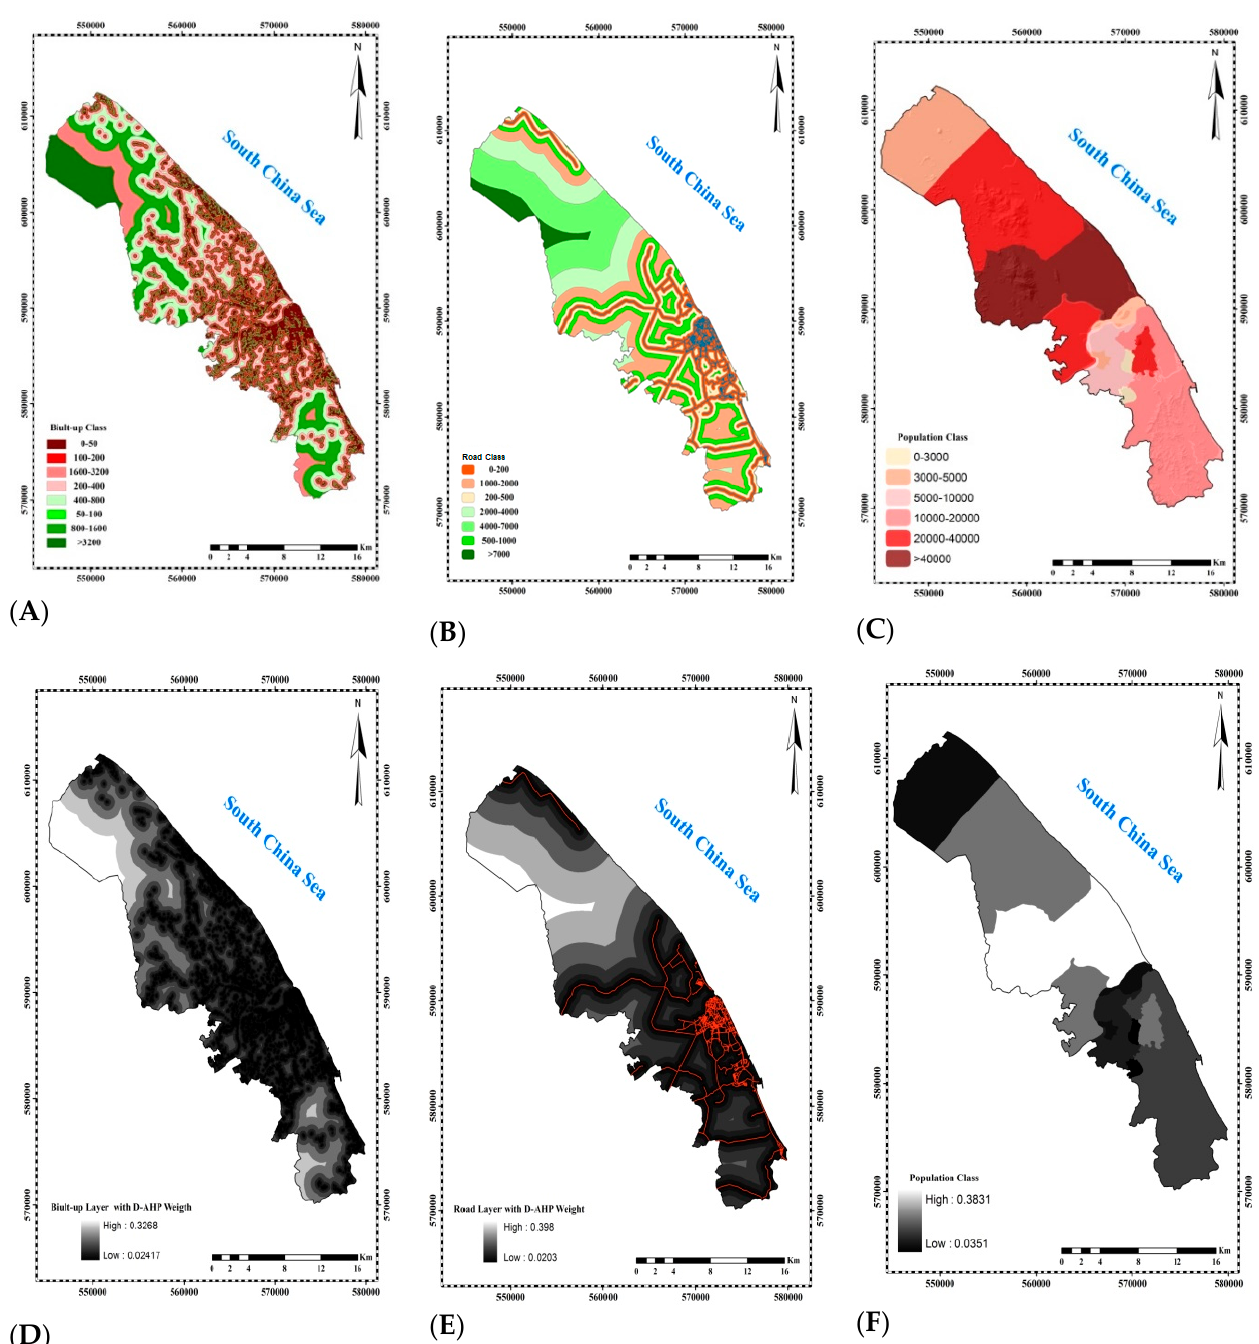
Figure 7. Human activity GIS layers: ( A ) Built-Up class, ( B ) Road class, ( C ) Population class. Human activity GIS layers after calculating with Delphi-AHP weights: ( D ) Built-Up layer, ( E ) Road layer, ( F ) Population layer.